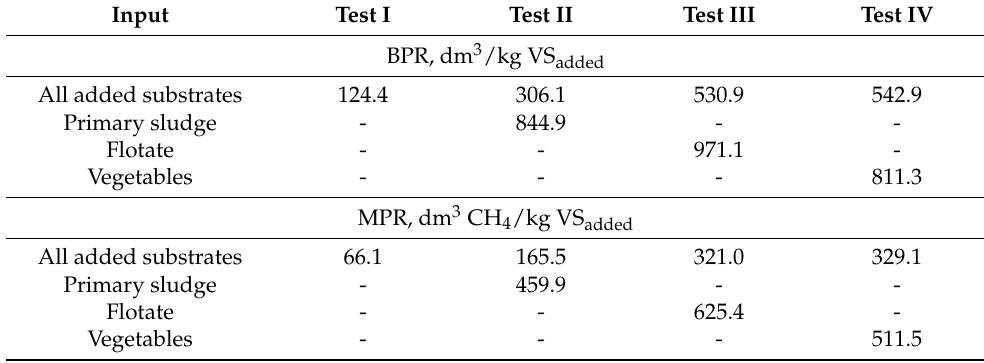
Table 3. Unit production of biogas and methane during methane fermentation (T = 36 ◦ C, t = 30